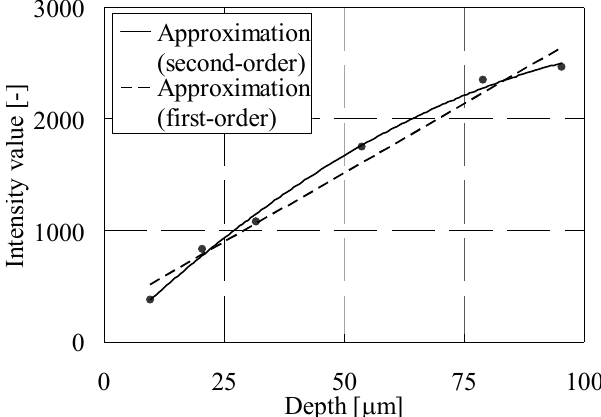
Fig. 5 Calibration curve between thickness and fluorescence